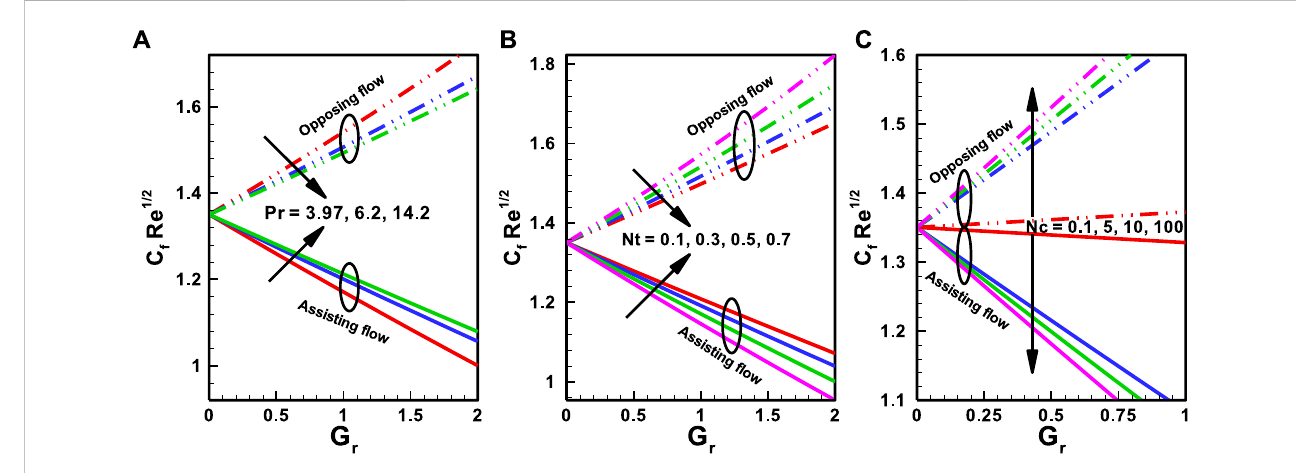
FIGURE 7 Variation of Coef fi cient for Skin friction (A) Prandtl number P r , (B) The thermophoresis parameter N t (C) The ratio of buoyancy forces on the rescaled nanoparticle volume fraction N c .